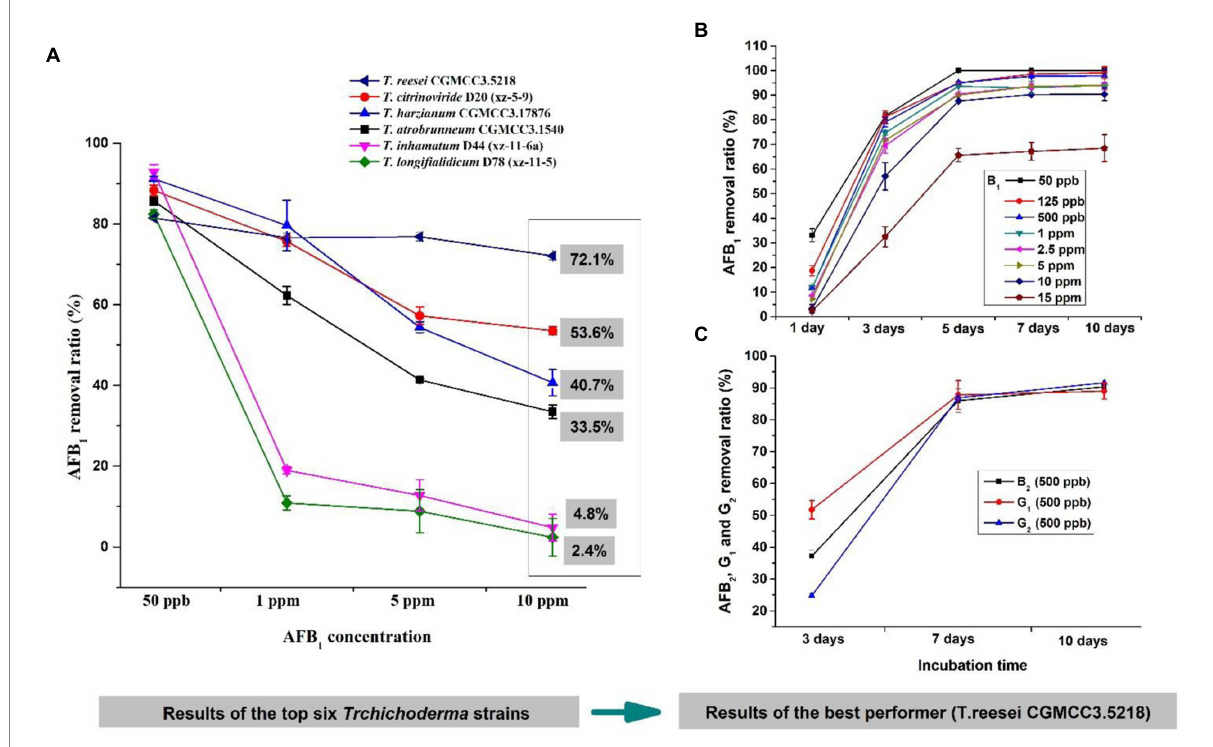
FIGURE 3 The candidate Trichoderma isolates for aflatoxin detoxification. (A) Removal ratios of aflatoxin B 1 (AFB 1 ) by T. reesei CGMCC3.5218, T. citrinoviride D20 (xz-5-9), T. harzianum CGMCC3.17876, T. atrobrunneum CGMCC3.1540, T. inhamatum D44 (xz-11-6a), and T. longifialidicum D78 (xz-11-5) cultured in yeast extract peptone dextrose (YPD) liquid medium, after 3 days of incubation at 28 ° C in the dark. (B) Removal ratios of AFB 1 at concentrations of 50 ng/kg to 15 μ g/kg by T. reesei CGMCC3.5218 after 1, 3, 5, 7, and 10 days of incubation. (C) Removal ratios of 500 ng/kg AFB 2 , AFG 1 , and AFG 2 by T. reesei CGMCC3.5218 cultured in YPD liquid medium, after 3, 7, and 10 days of incubation at 28 ° C in the